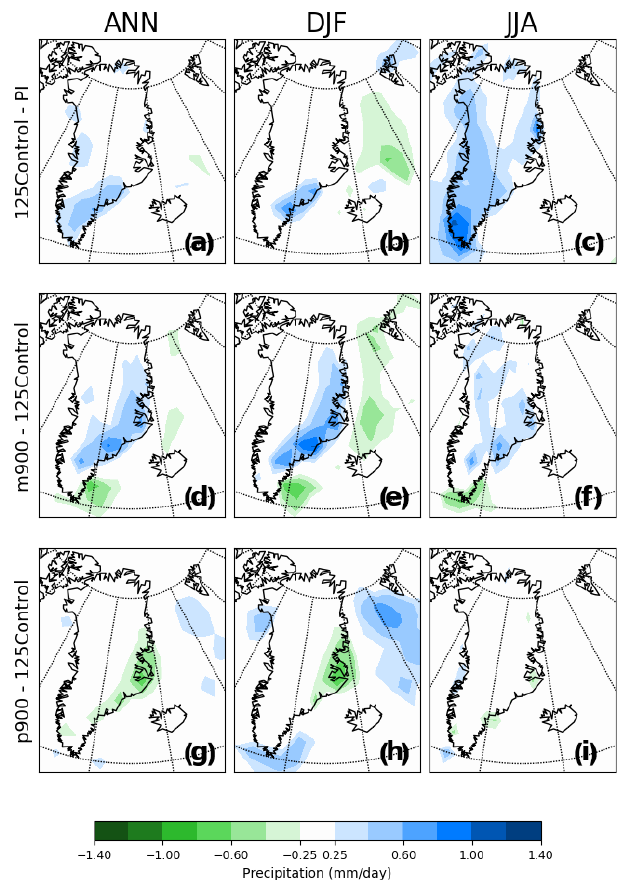
Figure 6. Annual (ANN), winter (DJF) and summer (JJA) precip- itation anomalies for m900 (d–f) and p900 (g–i) compared to the 125Control simulation. Also shown are precipitation anomalies for 125Control compared to the PI simulation (a–c) . Only the anoma- lies statistically significant at the 95% confidence level are dis-